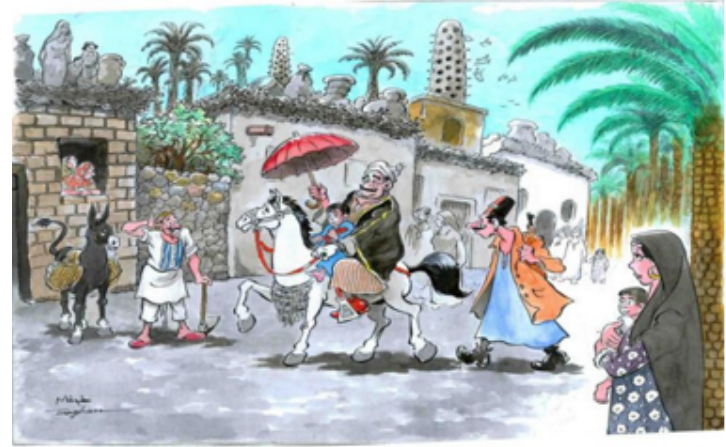
Figure 1 One of the work of the Artist Ali Tuygan